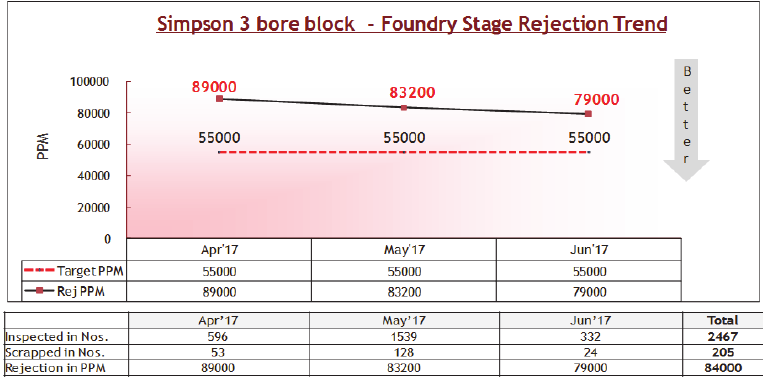
Fig. 4. 3-bore Block Foundry Rejection